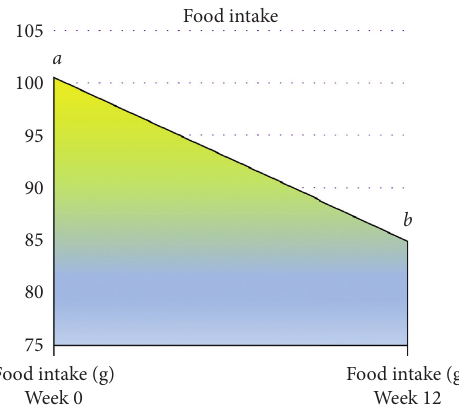
Figure 1: Follow-up of animal’s food intake during the experiment. Values are means of 8 rabbits per group. The results of all ex- periment groups were analysed using repeated measure analysis of variance (repeated measure ANOVA), with multiple comparisons done using the Bonferroni test. Mean difference is considered significant at p < 0 . 05. a,b Values differ significantly at p < 0 .